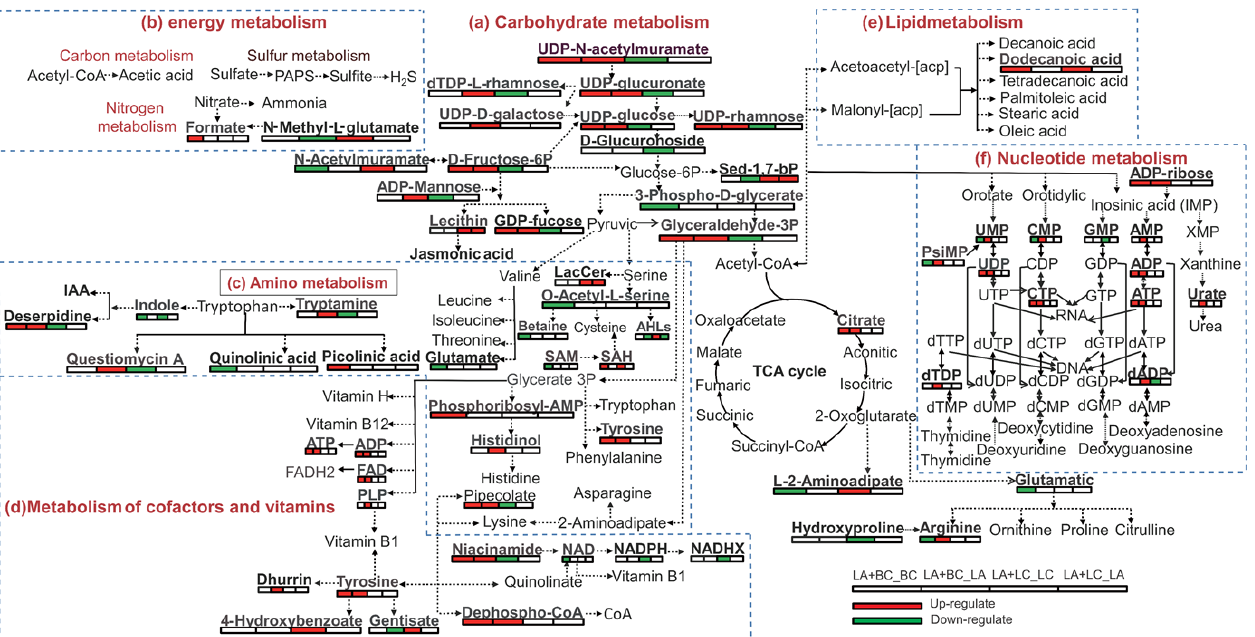
Figure 7. Visual analysis of metabolism network of carbohydrates, amino acids, fatty acids, nucleotides, cofactors-vitamins, and second productions in bacterial cultures. The data represent the expression of metabolites in the bacterial co-culture compared with the single strain. Note: red indicates up-regulation, green indicates down-regulation, and blank indicates no significant differences.